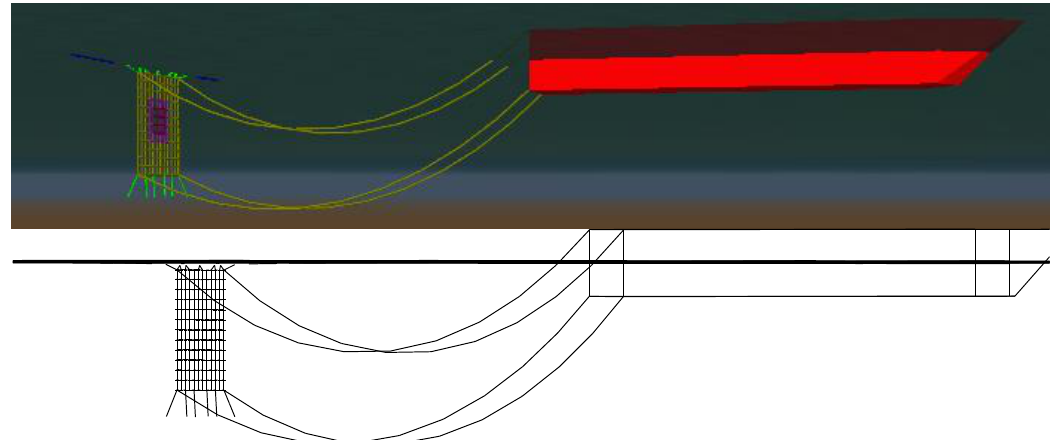
Figure 6. The flexible trawl system in OrcaFlex.